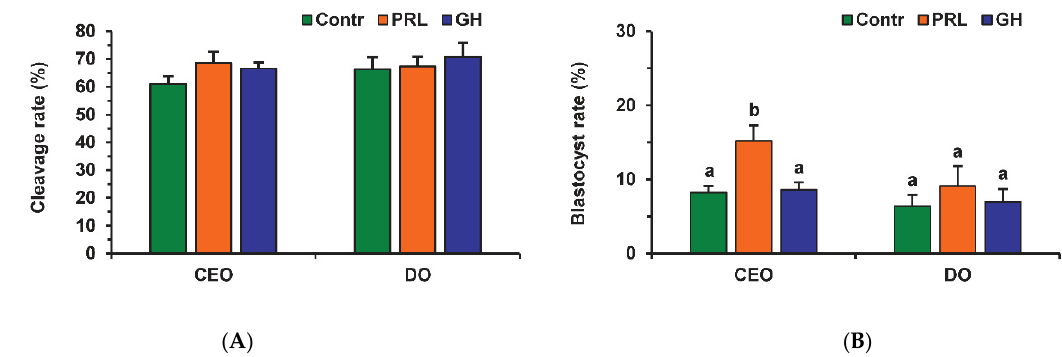
Figure 11. Effects of PRL (50 ng/mL) and GH (10 ng/mL) during the 12 h aging of bovine CEOs and DOs on the oocyte developmental capacity: ( A ) cleavage rate, ( B ) blastocyst rate. Data represent means ± SEM of 6 replicates using 173–184 oocytes per treatment. Means marked with different letters differ significantly (at least p < 0.05).